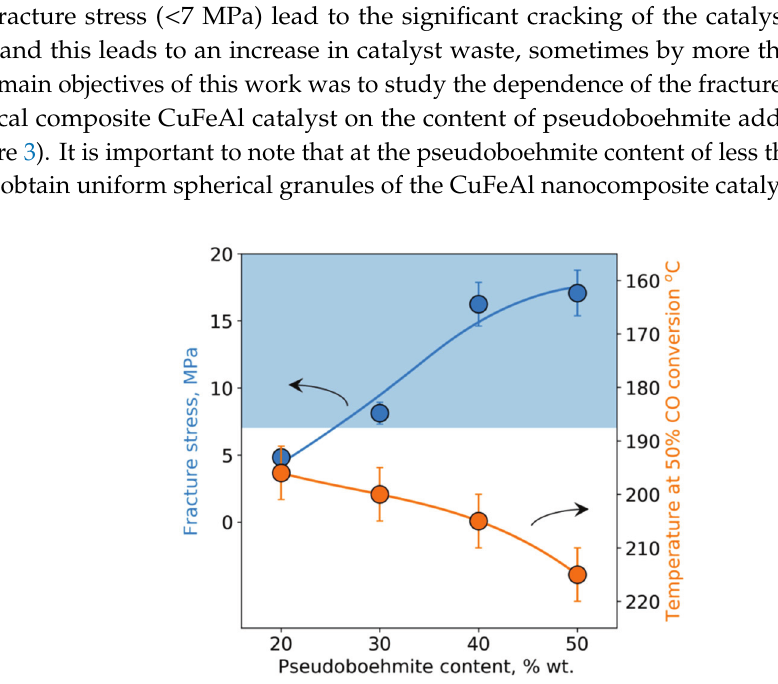
Figure 3. Dependence of the strength (the blue curve and circles) and activity (the orange curve and circles) of the CuFeAl nanocomposite catalyst on the pseudoboehmite content. The blue area is a zone of the required strength.